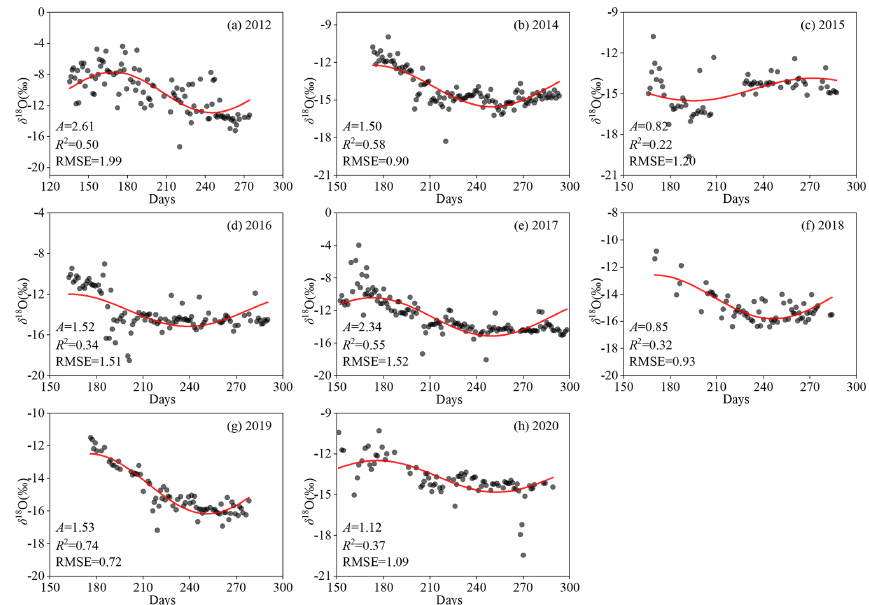
Figure 10. Fitted sine-wave regression models to δ 18 O in stream water in Xiaoliuyu catchment during 2012 and 2014–2020. A is the amplitude, and RMSE is root mean square error for the modelled isotopic signature. Table 4. Relationships between active layer thickness, soil temperature, air temperature, precipitation, NDVI, and MRT. x indicates the factor as the independent variable. Regression based on mean MRT (days) Regression based on MRT uncertainty (days) Factor Regression equation R 2